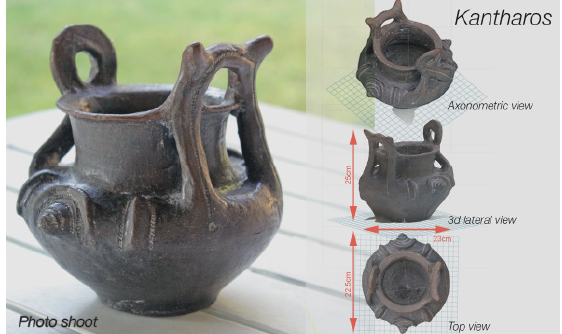
Figure 5. Photographic shots from which the Kantharos polygonal 3D model was obtained using the Recap Photo 3.1 From the survey to virtual reconstruction for immersion navigation, two case studies